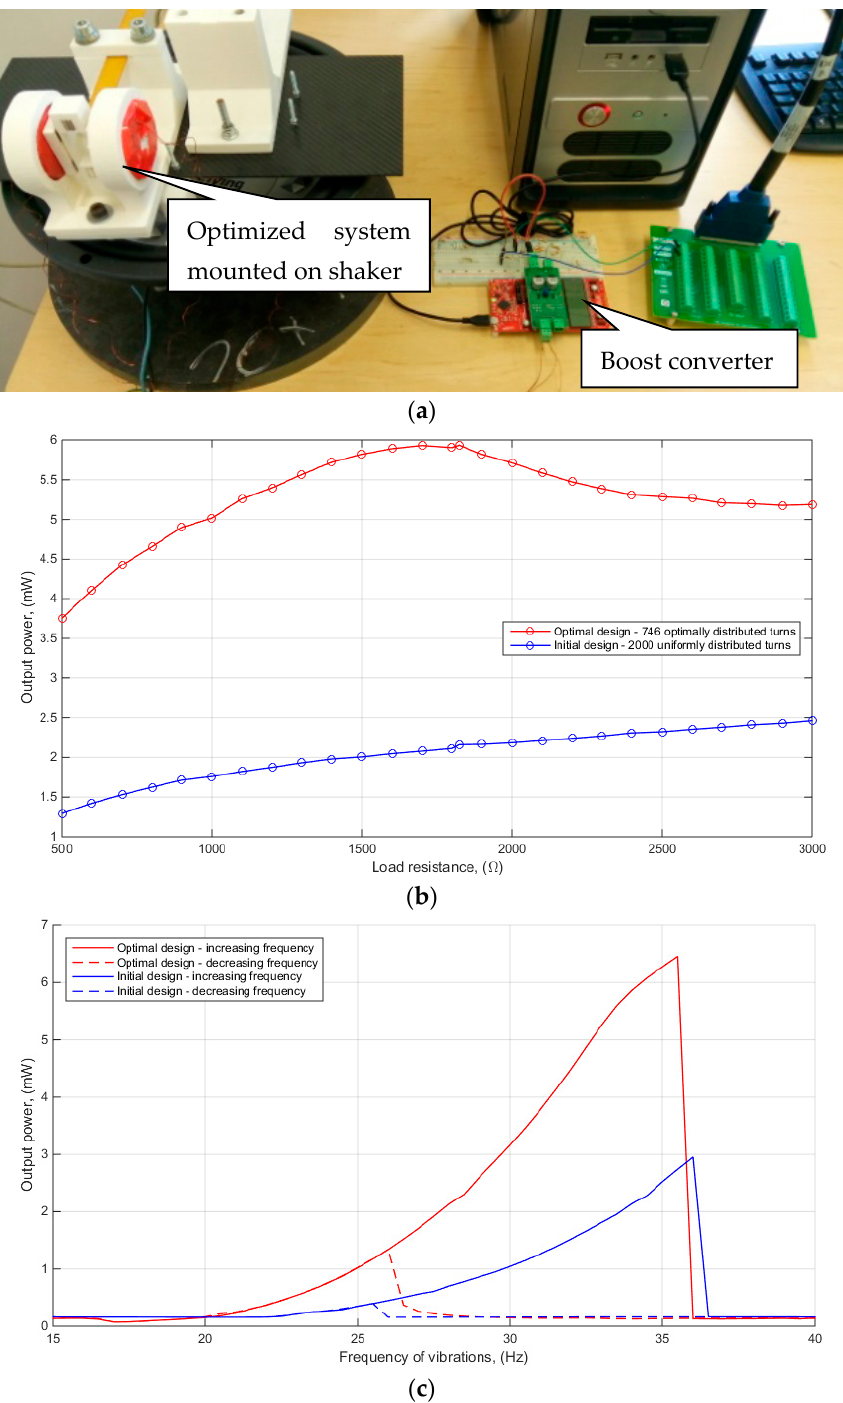
Figure 5. Measurements: ( a ) laboratory test-stand; ( b ) output powers vs. load resistance for initial and optimized designs at a vibration frequency equal to 34.5 Hz; ( c ) frequency characteristics for increasing and decreasing frequency of vibrations for load resistance R l equal to 1824 Ω . The results are obtained at accelerations applied to the system base equal to 1 g.